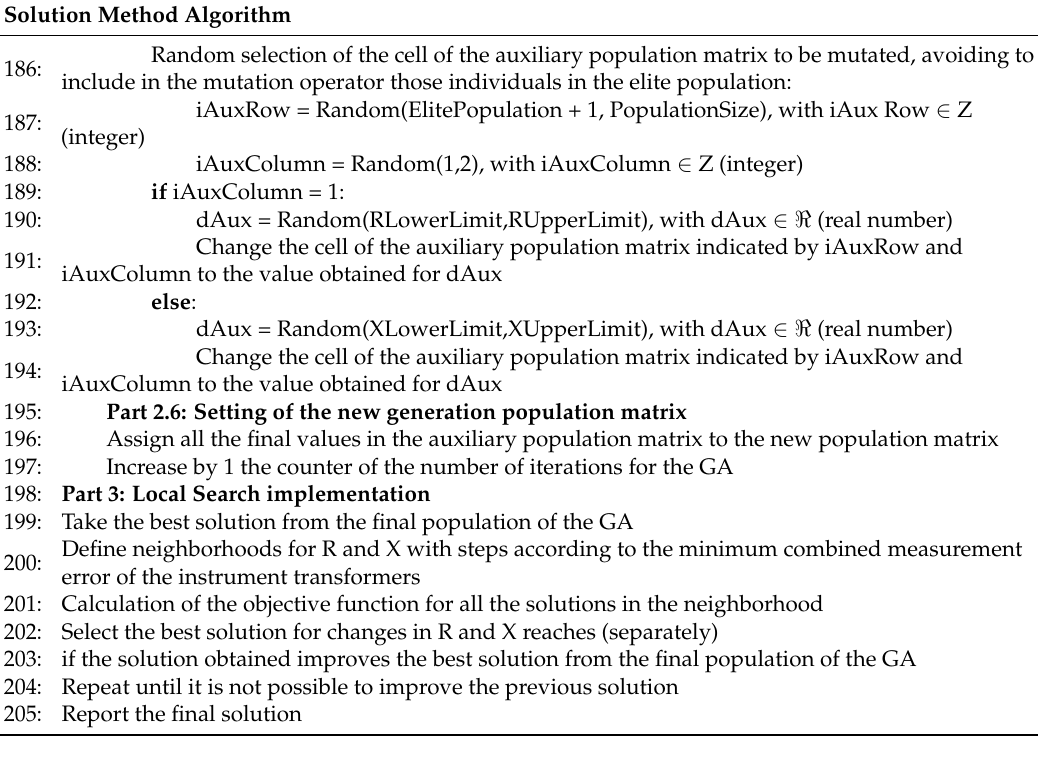
Solution Method Algorithm